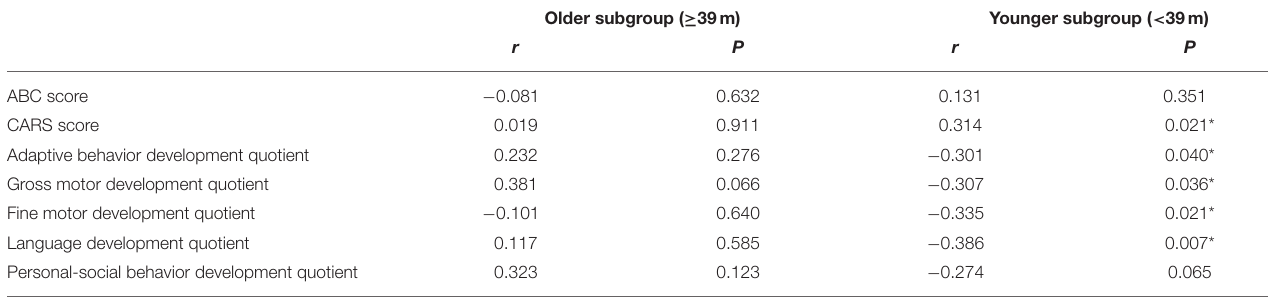
TABLE 4 | Correlations between screen time and ASD-related scale scores and development quotients in the older and younger